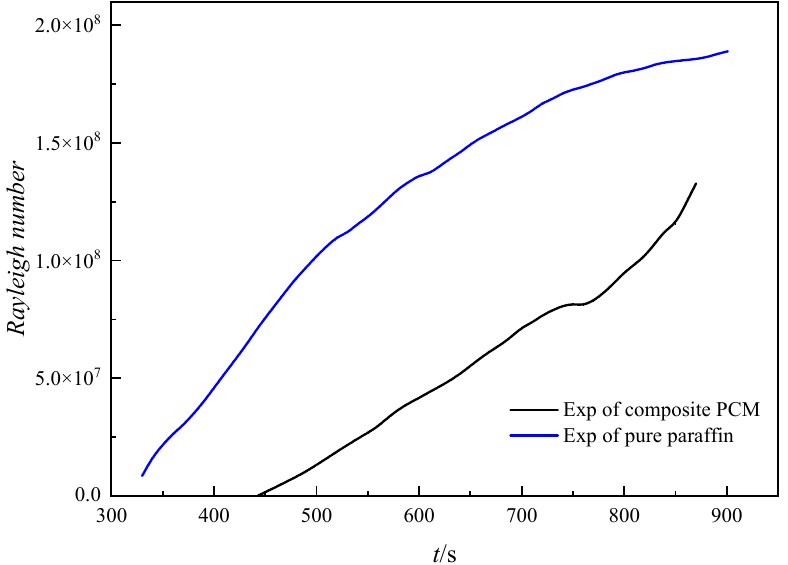
Figure 13. Rayleigh numbers of the pure paraffin and the composite